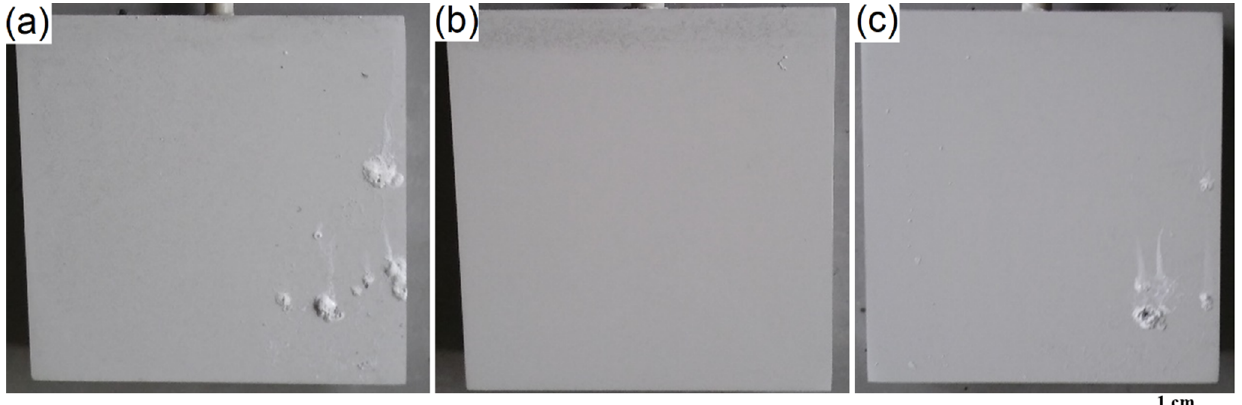
Figure 12. Images of the PEO coatings surface: ( a ) Base; ( b ) BF4; ( c ) F, after neutral salt spray test in 5 wt.% NaCl for 168 h.